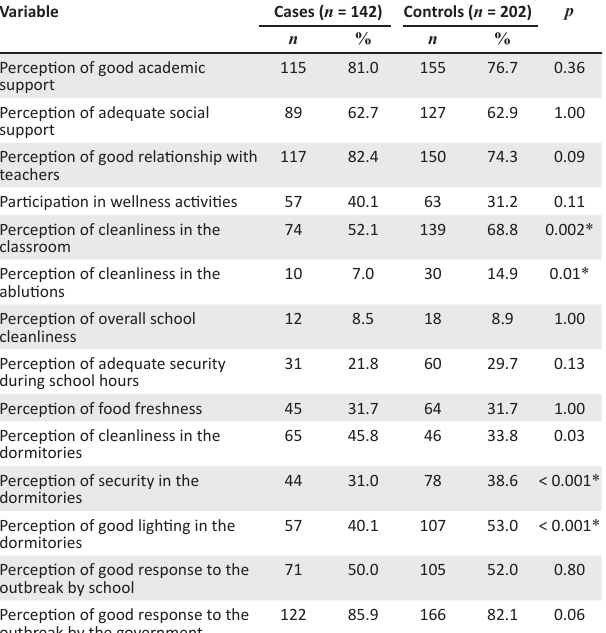
TABLE 3: Participants’ medical and psychological history. TABLE 2: Students’ perceptions of the school environment.